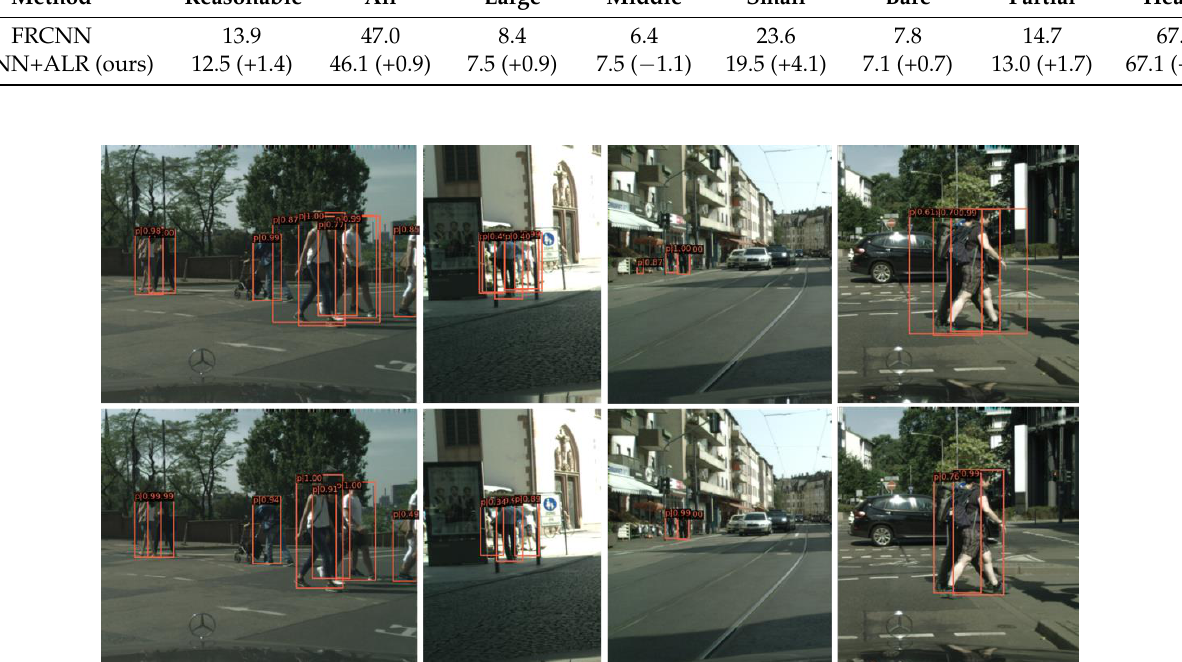
Figure 8. Qualitative results from the baseline method ( the first row ) and our FRCNN+ALR ( the second row ) in the CityPersons validation set.